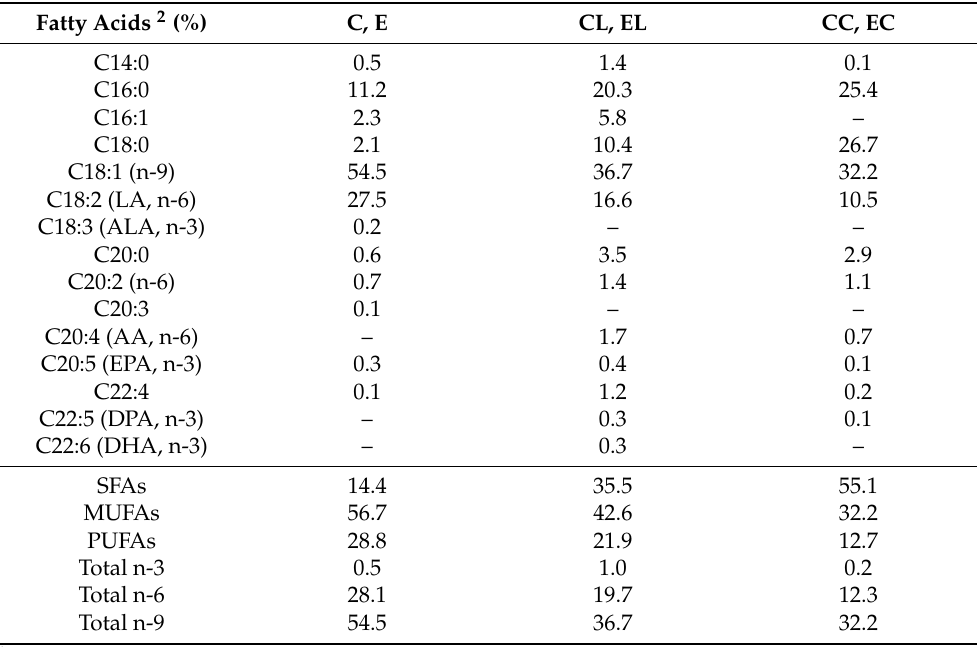
Table 2. Fatty acid composition of the experimental liquid diets 1